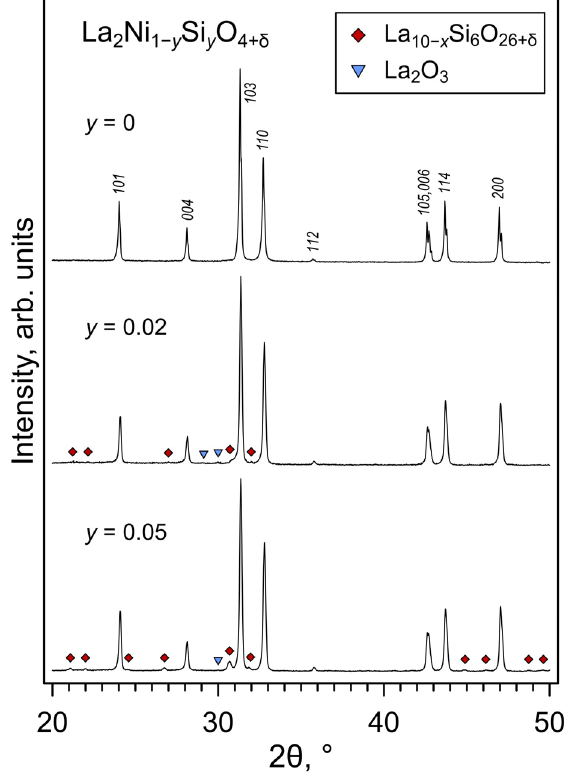
Figure 2. XRD patterns of La 2 Ni 1 − y Si y O 4+ δ ceramics sintered at 1450 °C for 5 h. Table 2. Lattice parameters and density of La 2 Ni 1 − y Si y O 4+ δ ceramics sintered at 1450 ◦